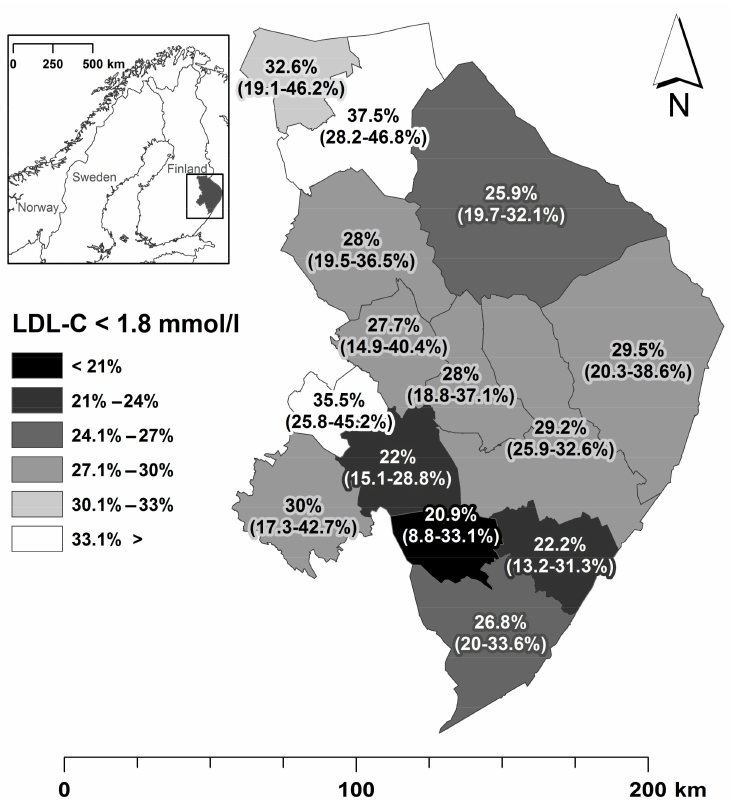
Figure 6. Low-density lipoprotein cholesterol (LDL-C) treatment target attainment among patients with ACS or PCI/CABC in North Karelia Hospital District in 2011–2014. (ACS = acute coronary syndrome, PCI = percutaneous coronary intervention, CABC = coronary artery bypass